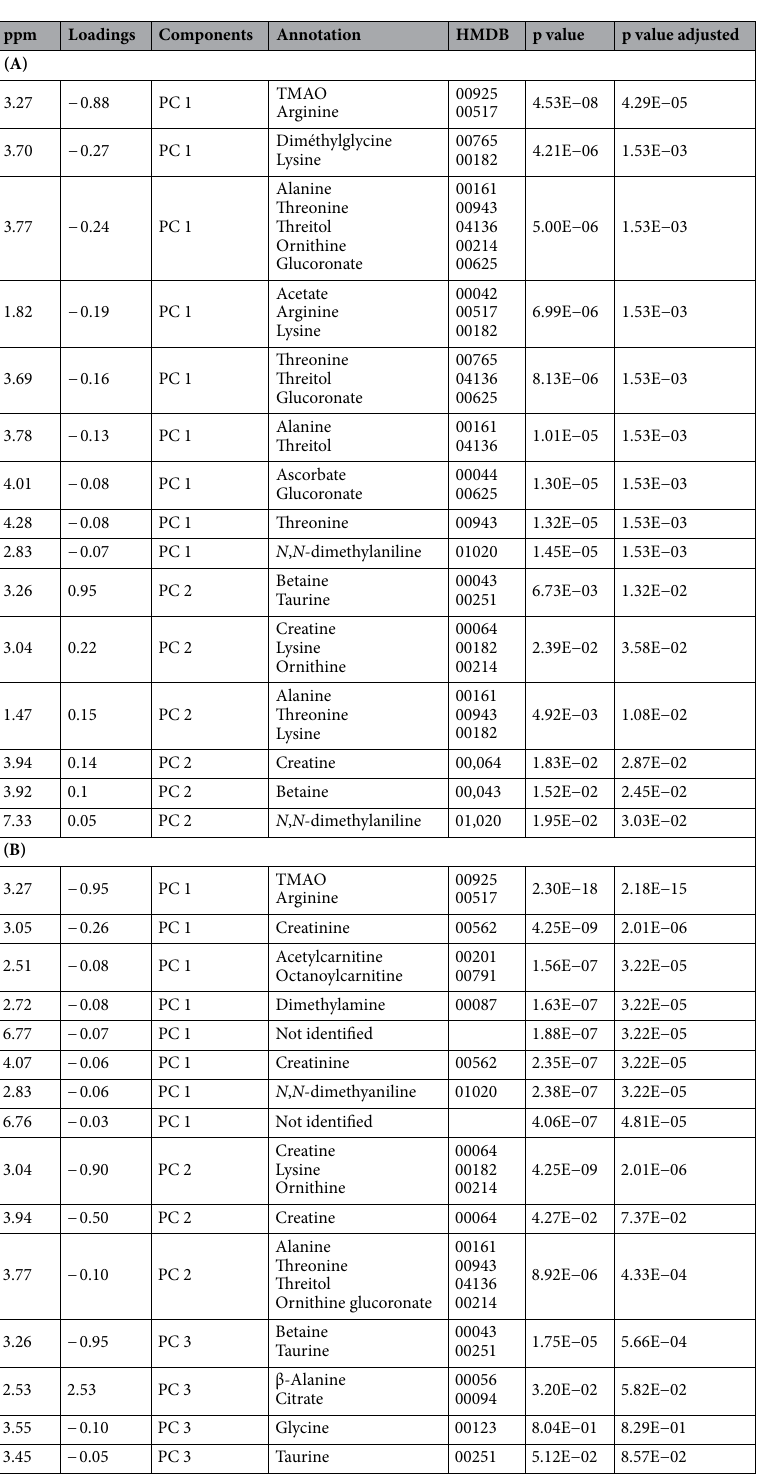
Table 1. Metabolites identified as key molecules significantly correlated with (A) UPJO vs TD and (B) UPJO vs controls. Loadings correspond to the weight of the variables on SPLS-DA components. NMR shifts may correspond to several metabolites (annotation). HMDB column indicate the reference in the HMDB database of each annotated NMR shifts. A parametric (p-value) and non-parametric (p-value adjusted) test were applied to verify significance for NMR